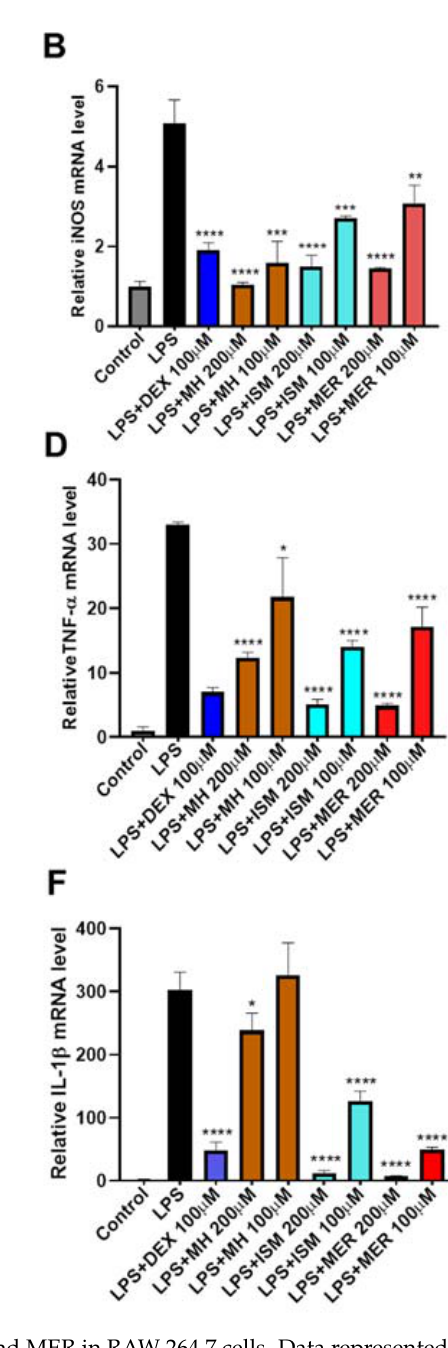
Figure 8. Anti-inflammatory effect of MH, ISM, and MER in RAW 264.7 cells. Data represented the mean ± SEM of three independent experiments in triplicate. * p < 0.05, ** p < 0.01, *** p < 0.005, **** p < 0.001 vs. LPS group. ( A ) Inhibition of MH, ISM, and MER on LPS-induced NO production. ( B ) Inhibition of MH, ISM, and MER on LPS-induced iNOS mRNA level. ( C ) Inhibition of MH, ISM, and MER on LPS-induced Cox-2 mRNA level. ( D ) Inhibition of MH, ISM, and MER on LPS-induced TNF- α mRNA level. ( E ) Inhibition of MH, ISM, and MER on LPS-induced IL-6 mRNA level. ( F ) Inhibition of MH, ISM, and MER on LPS-induced IL-1 β mRNA level.